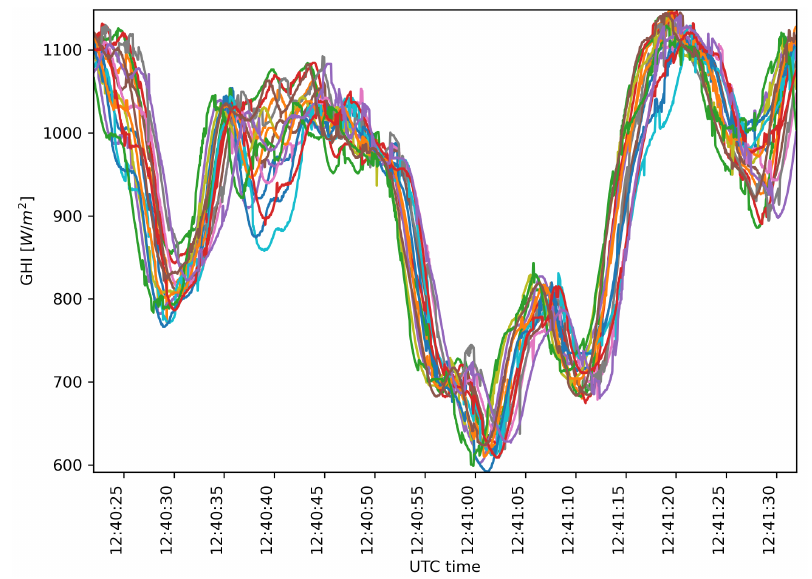
Figure 14. 60 s of 16 irradiance time series captured from WSN on 10 February 2022 starting at 12:40:22 UTC time.